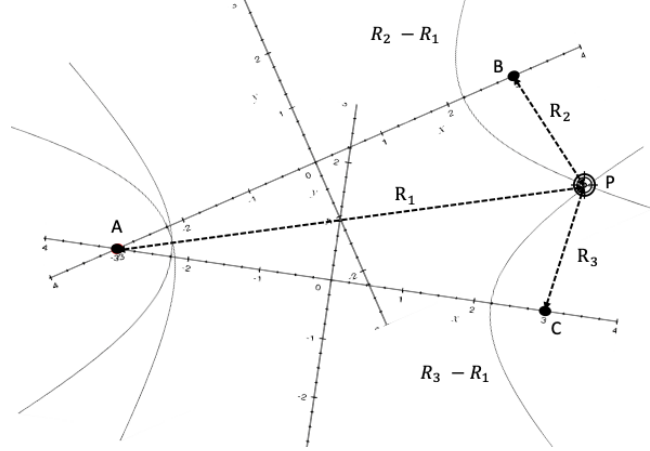
Figure 4. TDOA—based distance measurement.